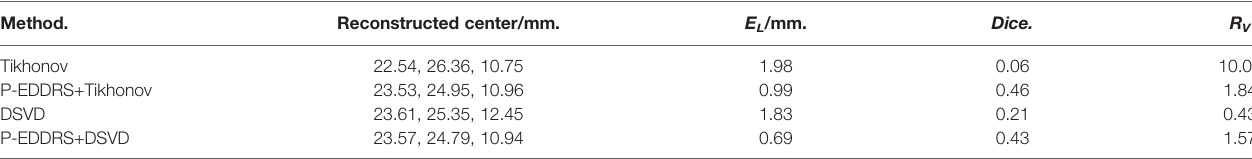
TABLE 7 | Quantitative evaluation results of the CLT subcutaneous breast experiments. Method.